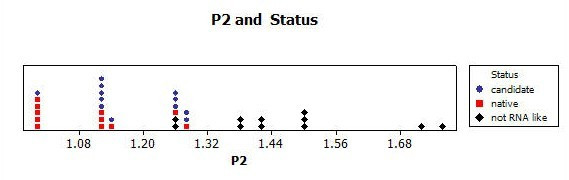
Dot plot for P2.